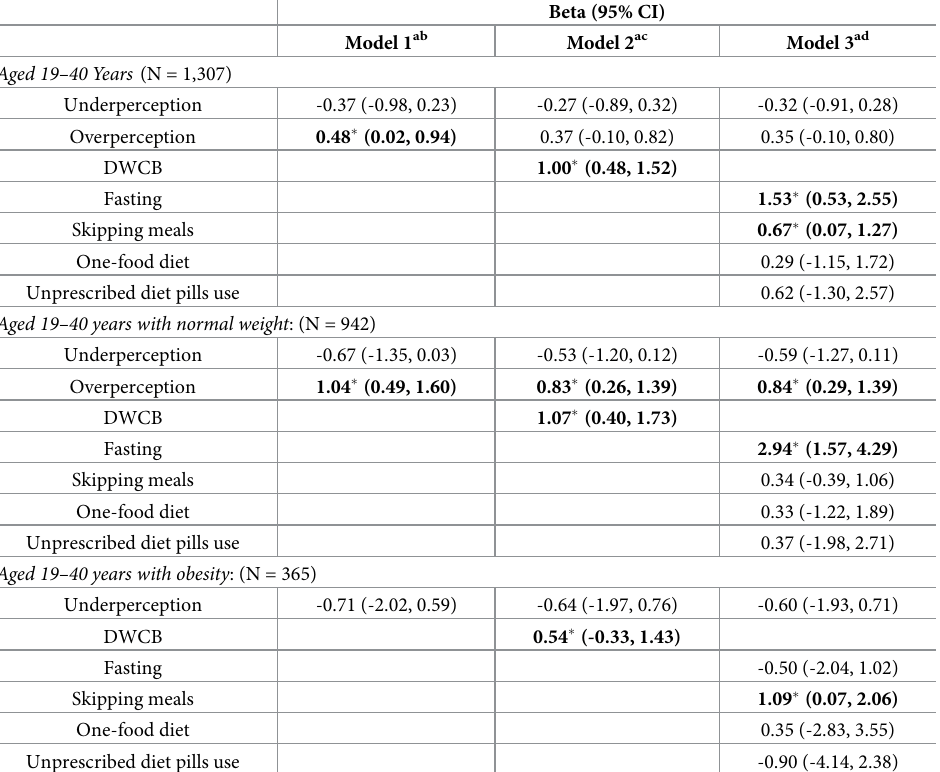
Table 4. Association of weight status perception pattern and disordered weight control behaviors with depressive symptoms (PHQ-9K) among Koreans aged 19–40 years with BMI > = 18.5kg/m 2 and no history of